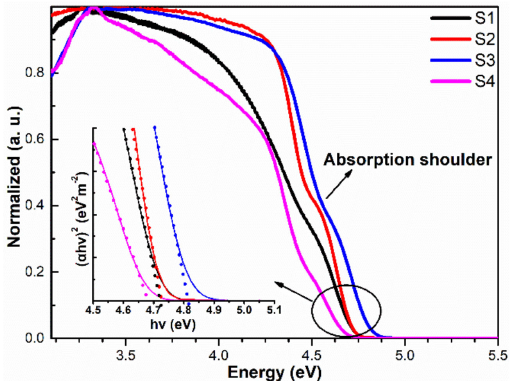
Figure 3. The optical transmission spectra of four samples of Nb-doped β -Ga 2 O 3 at room temperature, and the bandgap of the four samples calculated